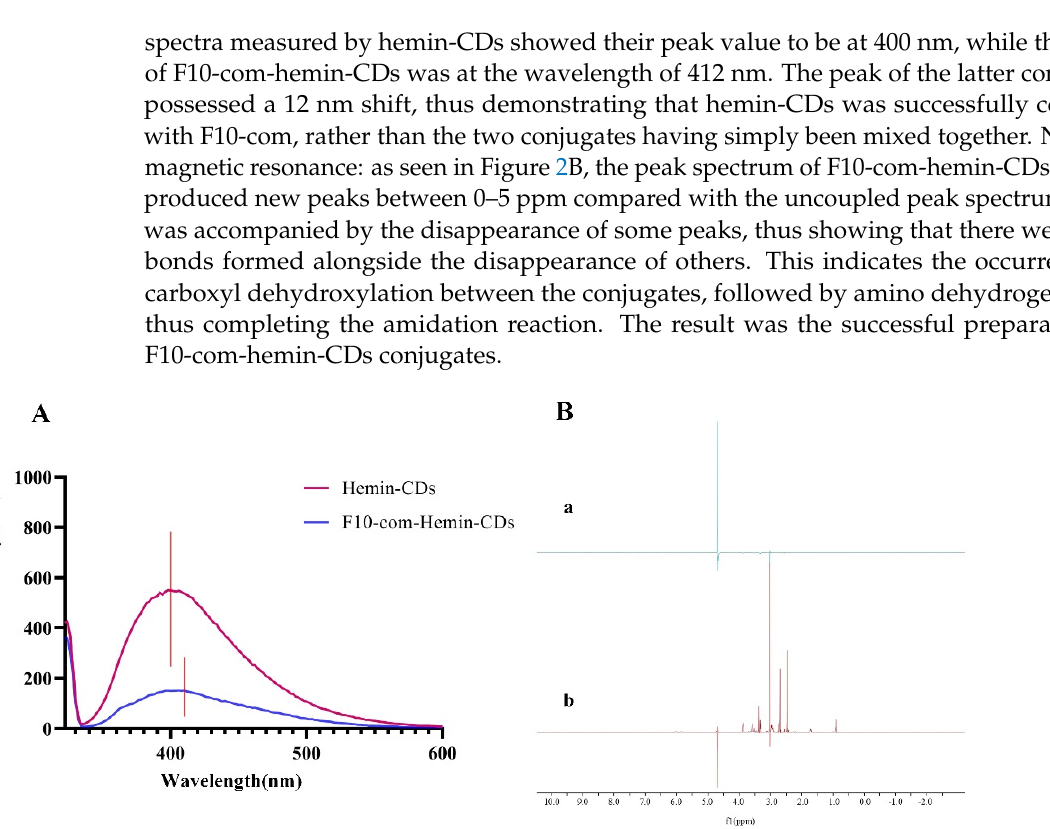
Figure 1. Characterization of hemin-CDs. ( A ) TEM of hemin-CDs conjugates. ( B ) The size of he- min-CDs.